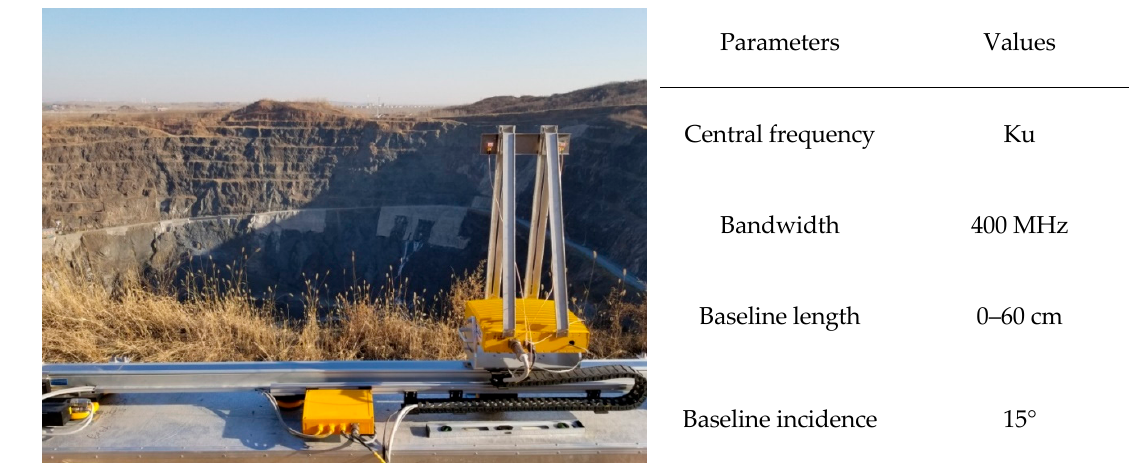
Figure 7. Sketch map of the GB-InSAR system and the experiment field.